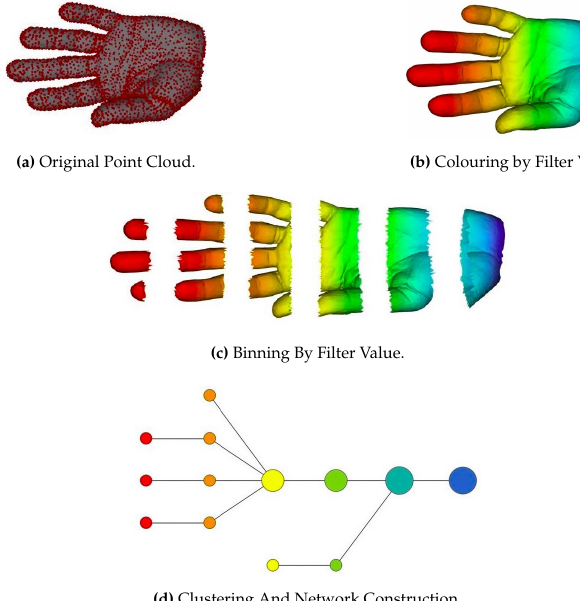
Figure 10. Illustration of a TDA Pipeline. (a) A 3D object (hand) represented as a point cloud. (b) A filter value is applied to the point cloud, and the object is now coloured by the values of the filter functions. (c) The dataset is binned into overlapping groups. (d) Each bin is clustered, and a network is built. The figure is originally from